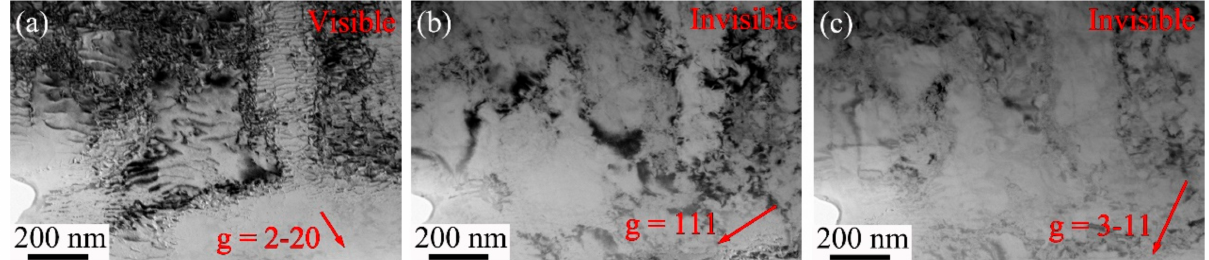
Figure 8. The bright-field images of dislocation under two-beam diffraction conditions for Figure 7a: ( a ) g = 2–20, ( b ) g = 111, and ( c ) g =